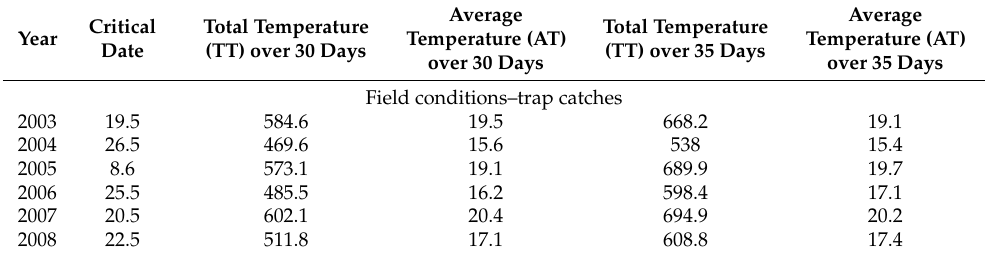
Table 1. Winna G ó ra research findings accounted for in the cutworm (by trap baits) control study for 2003–2008.